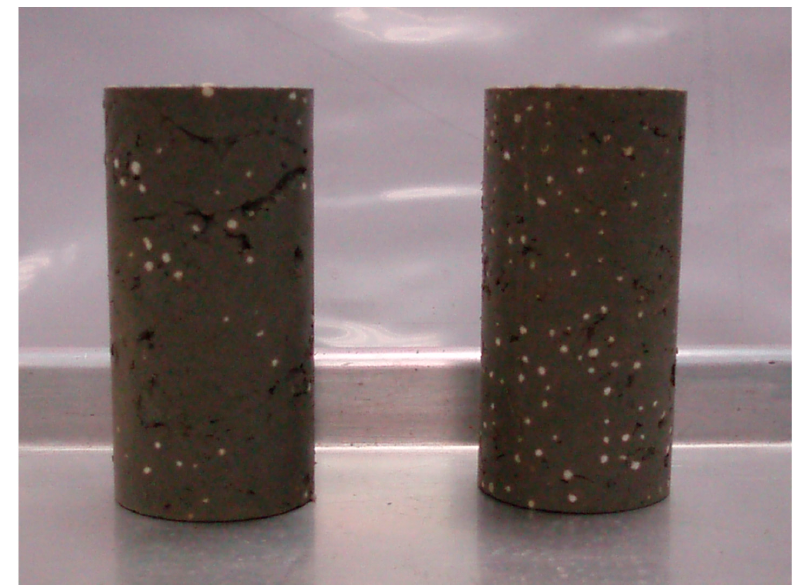
Figure 4. Prepared soil samples for Singapore marine clay (EPS: 1% for left and 2% for right).